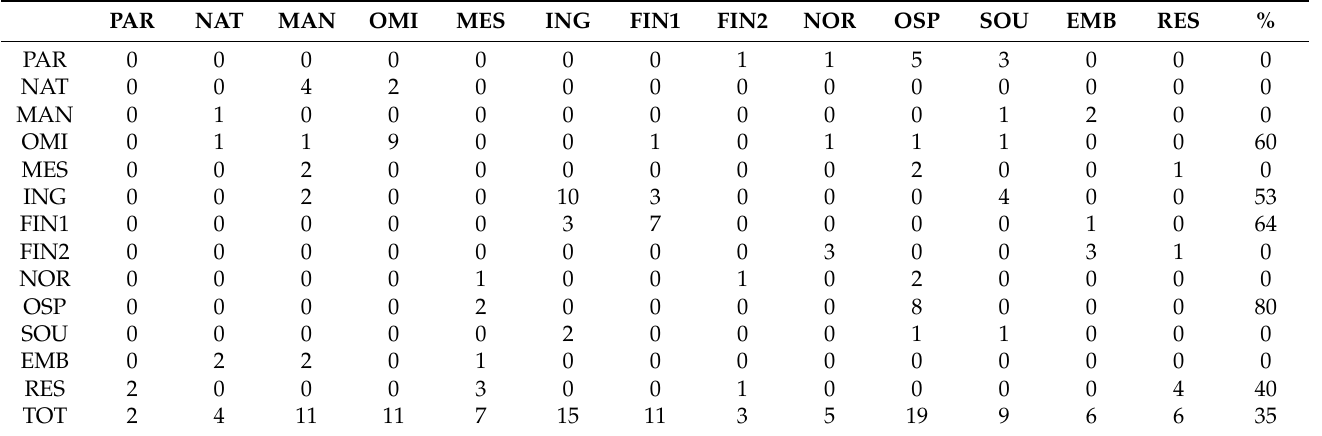
Figure 2. Elemental ratios of Sr and Ba to Ca for water samples collected from rivers and tributaries within the Williston Reservoir watershed. Locations for samples from each watershed are shown in Figure 1. Mainstem rivers are indicated as large, closed circles, tributary streams are indicated as small, closed circles, embayments are indicated as open, large circles with color defining the mainstem river, and samples collected from different locations in the reservoir are indicated as open squares. Ellipses drawn around reservoir (solid line) and embayment (dashed line) data define 95% confidence intervals for elemental signatures for each location. Small, closed circles inside open diamonds indicate water chemistries from tributary streams where mature Kokanee spawners were sampled. Table 1. The percentage of correct classification determined by discriminant function analysis (DFA) for water samples collected from watersheds within the Williston Reservoir catchment.